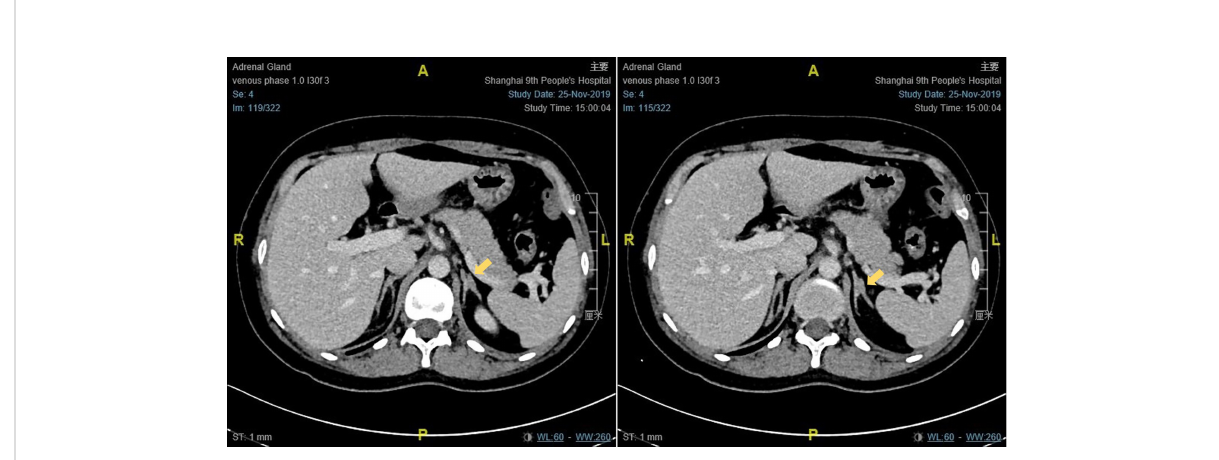
FIGURE 2 The enhanced CT scanning result of proband